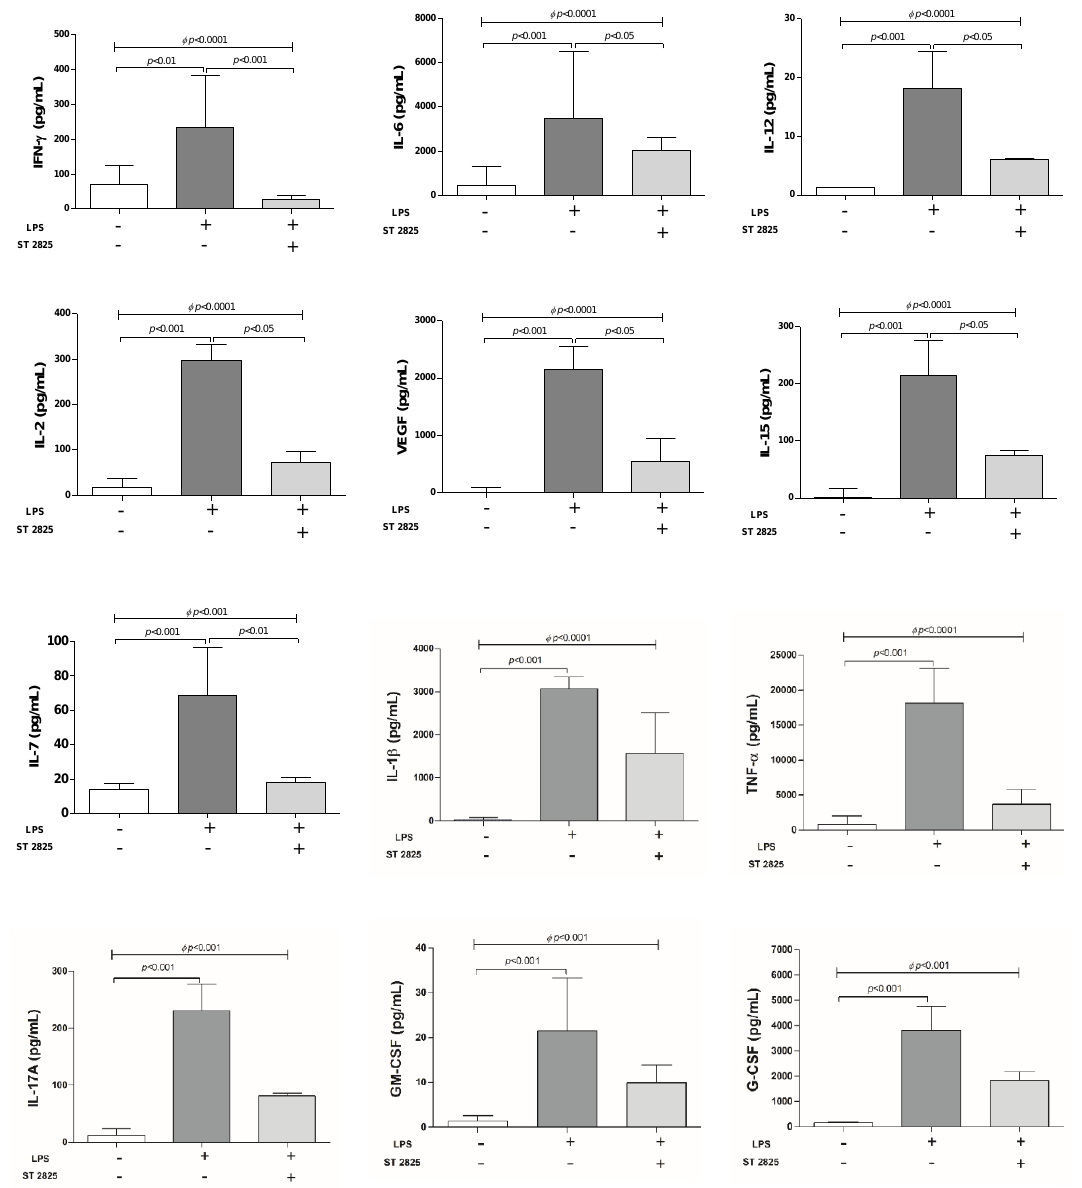
Figure 2. Effect of ST2825 on inhibition of pro-inflammatory cytokine secretion in the supernatant of LPS-stimulated PBMC. The soluble pro-inflammatory cytokines were determined in the PBMC supernatant of HBD (n = 10). PBMC (1 × 10 6 cells per well at a final volume of 1 mL) were cultured for 24 h under three different conditions: First, RPMI medium alone; second, LPS (30 ng/mL) and third, LPS (30 ng/mL) plus ST2825 (30 μM). Data provided in median and interquartile ranges ( Φ Kruskal-Wallis test and multiple comparisons by Dunn’s test).